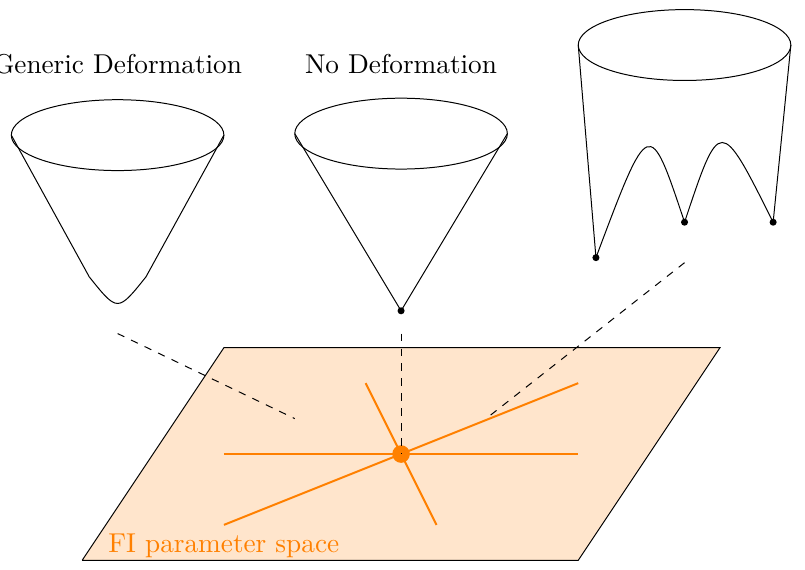
Figure 1 . Stratification of FI space (orange plane). At the origin, the HB (black) is singular while at a generic point it is resolved. The CB is lifted at a generic point; on the locus of a minimal deformation, the CB symmetry drops in rank by one, by definition of